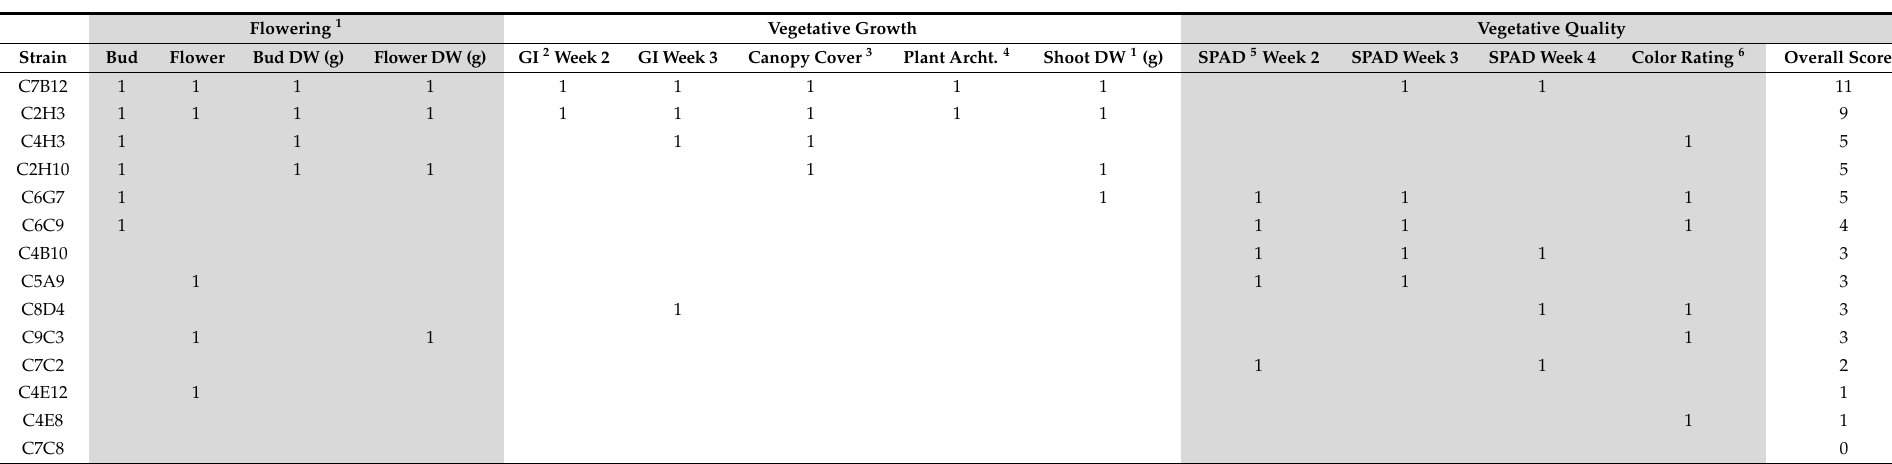
Table 2. A summary of the top-performing bacterial strains in each performance parameter in the greenhouse validation trial with Petunia × hybrida ‘Picobella Blue’. Flowering 1 Vegetative Growth Vegetative Quality